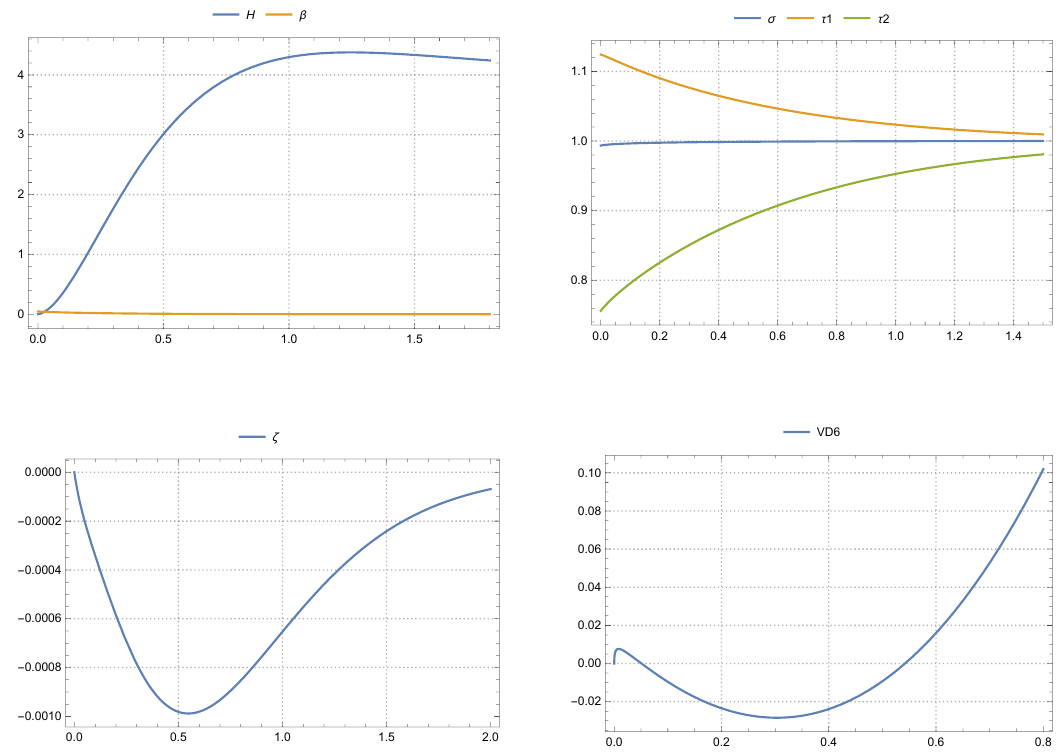
Figure 5 . Radial profile of the fields as a function of the coordinate u for a purely electric solution with parameters pξ = pξ = − 0 . 66 , pξ = − 0 . 089 and r = 1 / 4 , with worldvolume flux f = 1 for 1 3 2 H the probe D6 brane. This solution has temperature T = 0 . 013 . The potential V for fluxed D6 D 6 branes dips below zero, signalling the presence of stable